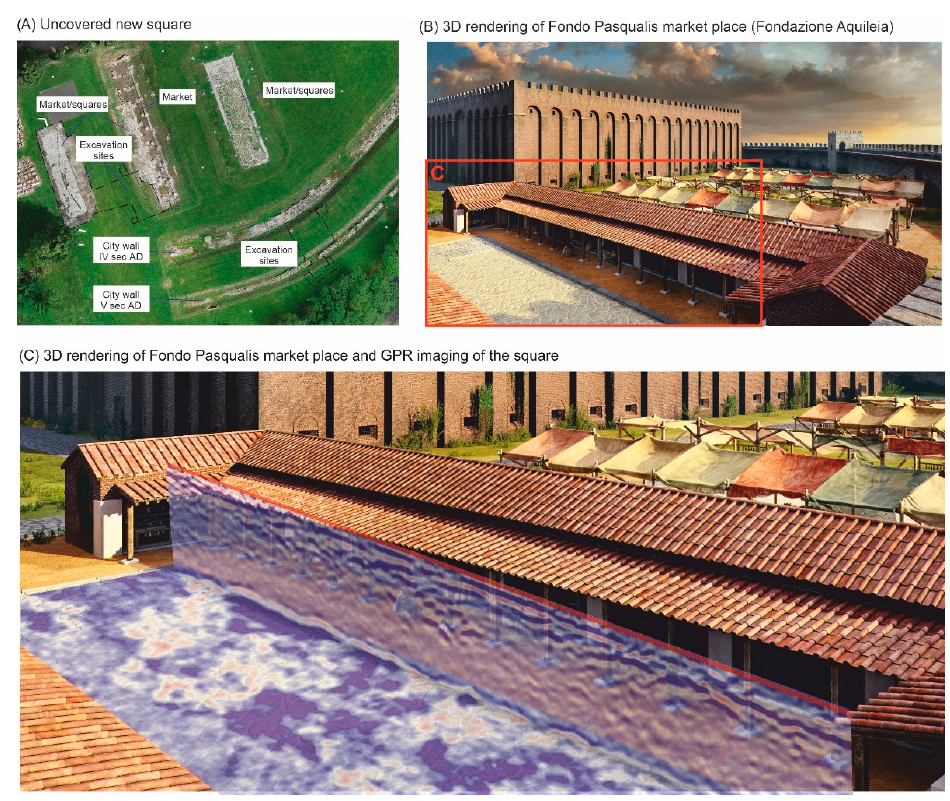
Figure 10. Final data integration and rendering of the main GPR-derived structures on photogrammetry, with outcomes from the new excavated areas. See text for details. Rendering courtesy of Fondazione Aquileia.